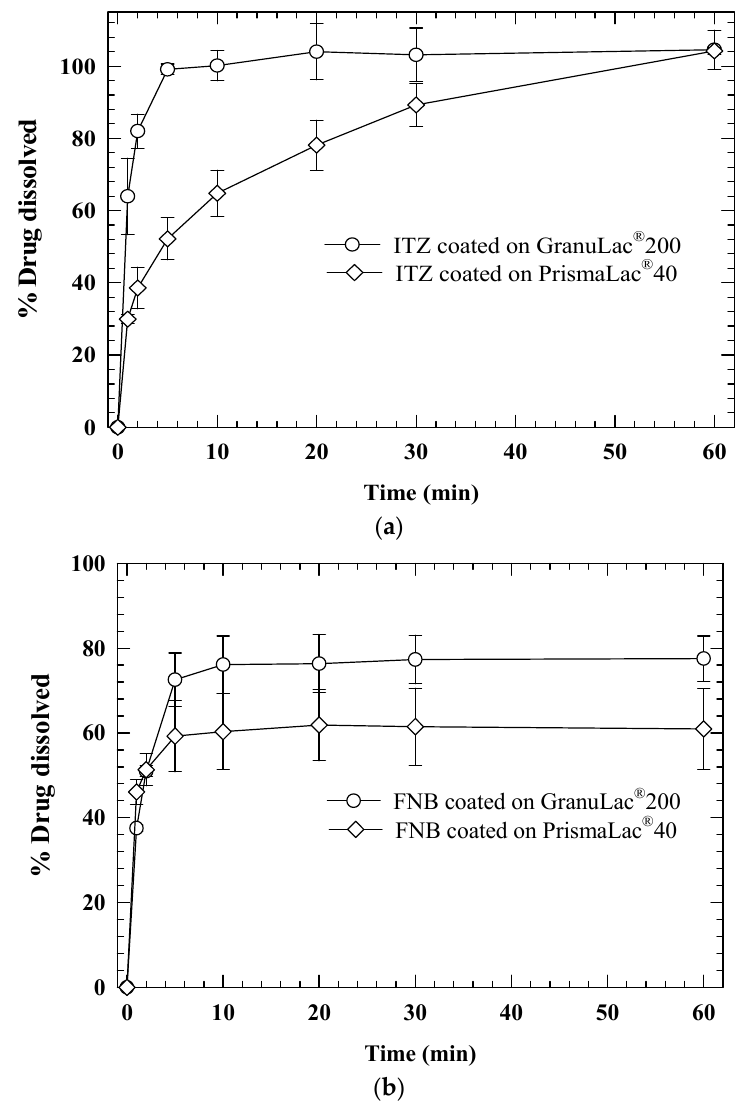
Figure 6. Comparison of drug release from the nanocomposite particles: ( a ) ITZ coated on PrismaLac 40 vs. GranuLac 200, ( b ) FNB coated on PrismaLac 40 vs. GranuLac 200, during the USP II dissolution test. Dissolution was performed using 7.2 mg/mL SDS solution for ( a ) and 2.88 mg/mL SDS solution for ( b ). (Figure adapted from Azad et al. [91] with permission from Elsevier, www.elsevier.com).